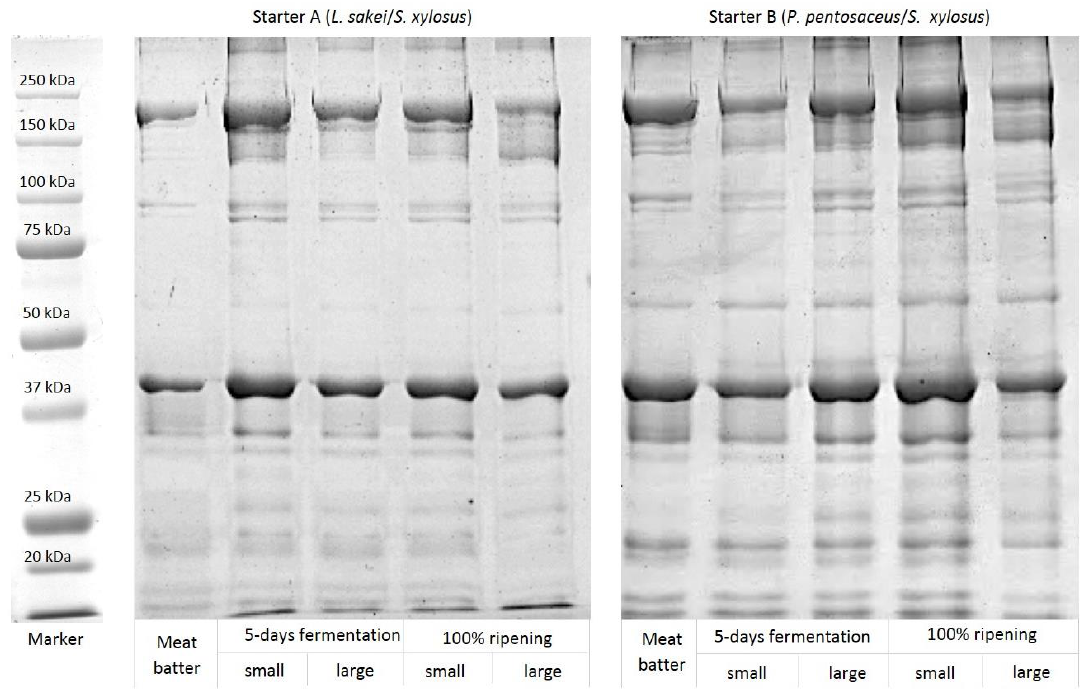
Figure 3. SDS–Polyacrylamide gel electrophoretic patterns of myofibrillar proteins for sausages inoculated with different starters ( L. sakei / S. xylosus and P. pentosaceus / S. xylosus ) and have different diameters (large and small) during fermentation and ripening.